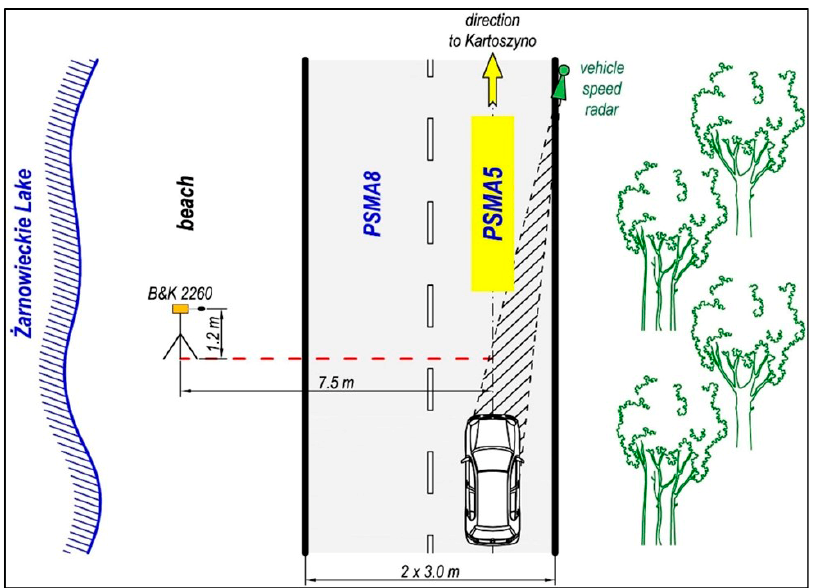
Figure 22. Scheme of the maximum sound level tests according to the CPB and SPB methods.